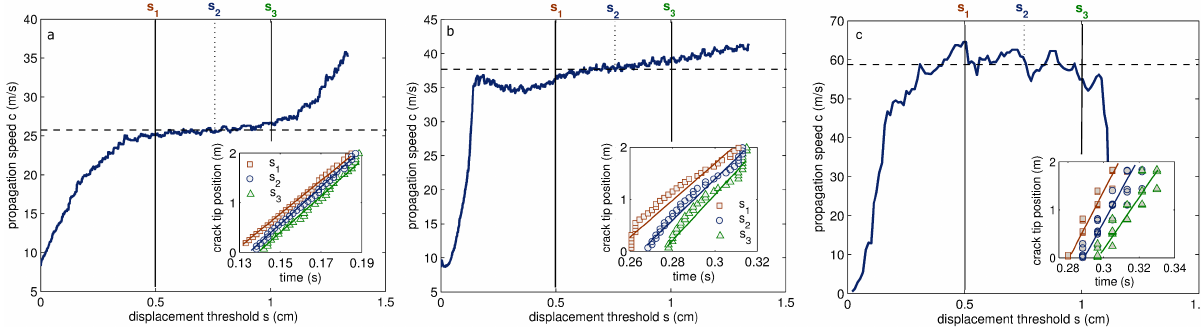
Figure A1. Propagation speed as a function of the vertical displacement threshold s . The insets represent the crack tip position as a function of time for three vertical displacement thresholds. The lines correspond to a linear fit. (a) simulation for ρ = 250kgm − 3 , E = 4MPa, D = 20cm, ψ = 0 ◦ ; (b) simulation for ρ = 250kgm − 3 , E = 7 . 8MPa, D = 20cm, ψ = 0 ◦ (c) experiment for a density ρ = 240kgm − 3